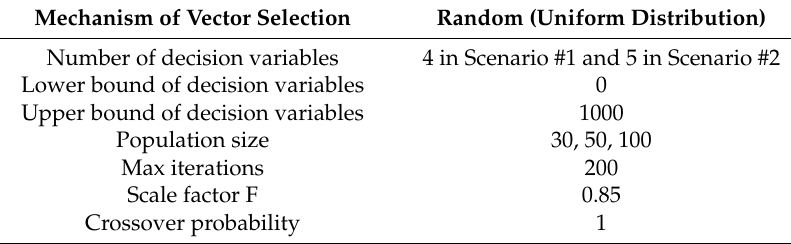
Table 4. The setting of parameter values in the DE